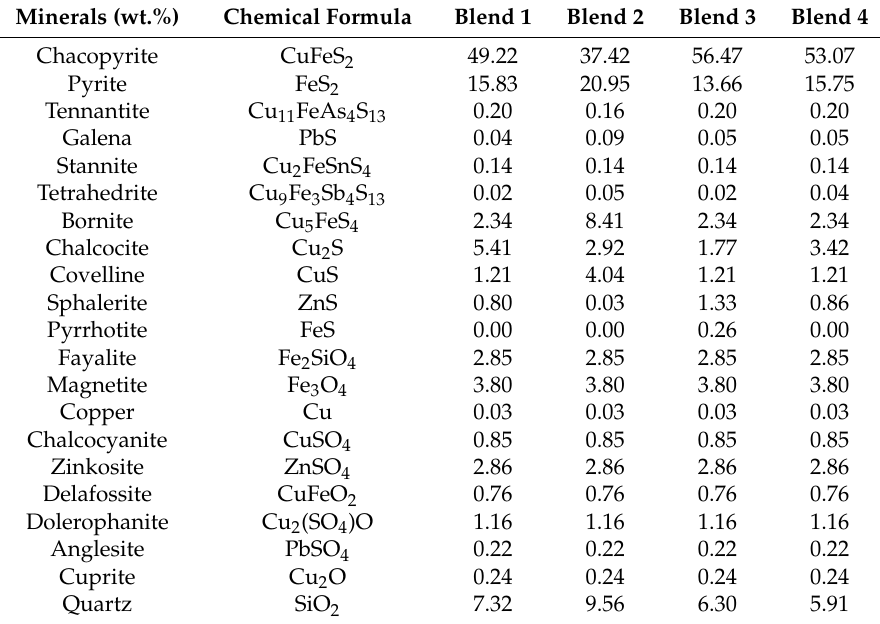
Table 9. Mineral composition of the blends